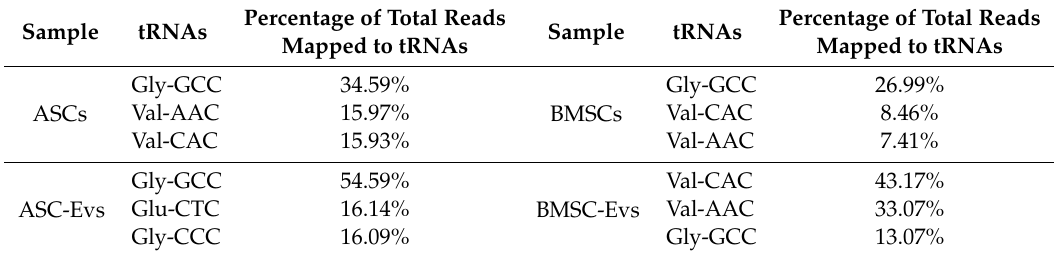
Table 4. Top 3 most abundant tRNAs in MSCs and MSC-EVs.